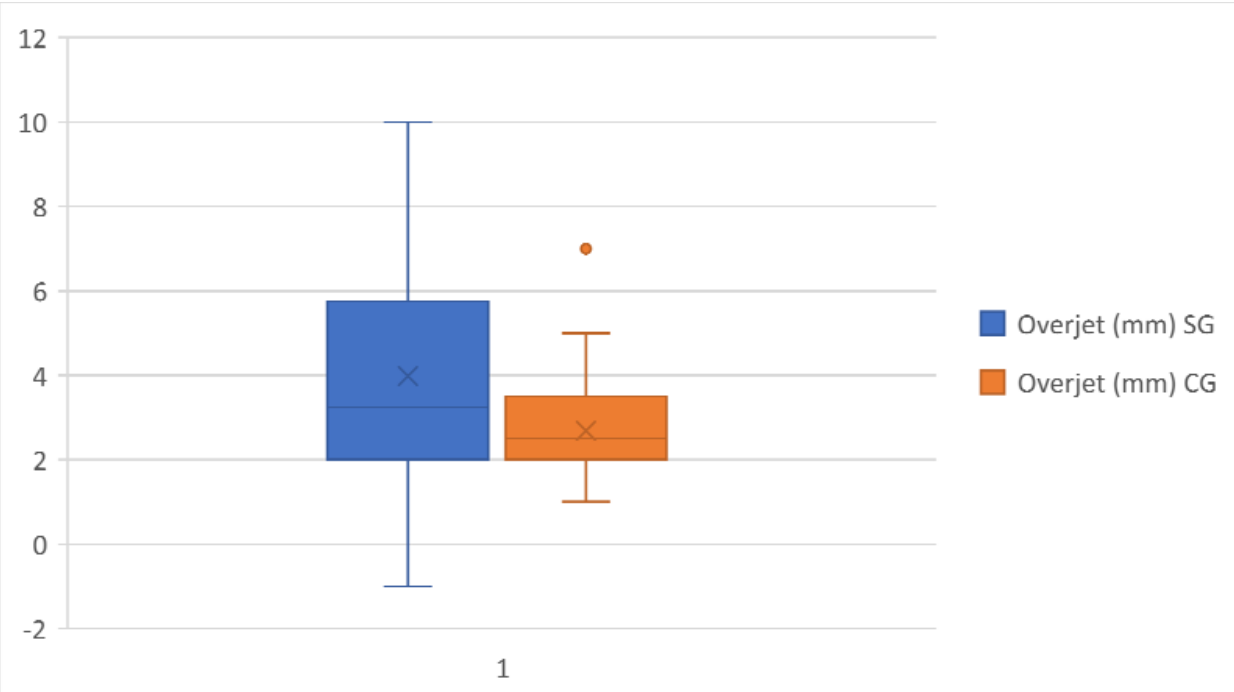
Sn–Sts, used in the present study to define the length of the upper lip, had a mean of